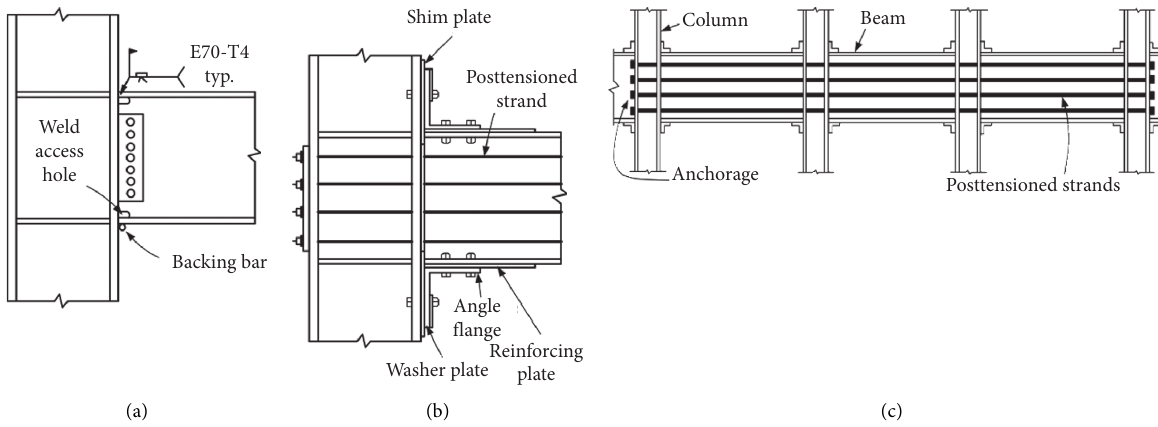
Figure 1: Schematic of connections and PT frame: (a) conventional weld connection; (b) posttensioned connection (adapted from [3]); (c) schematic elevation of one floor of a PT frame (adapted from